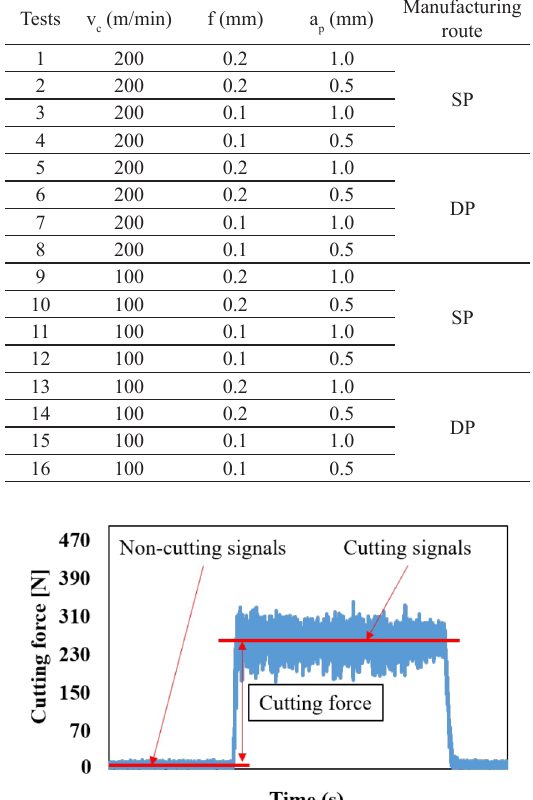
Table 2. Tests conducted with their respective cutting parameters.